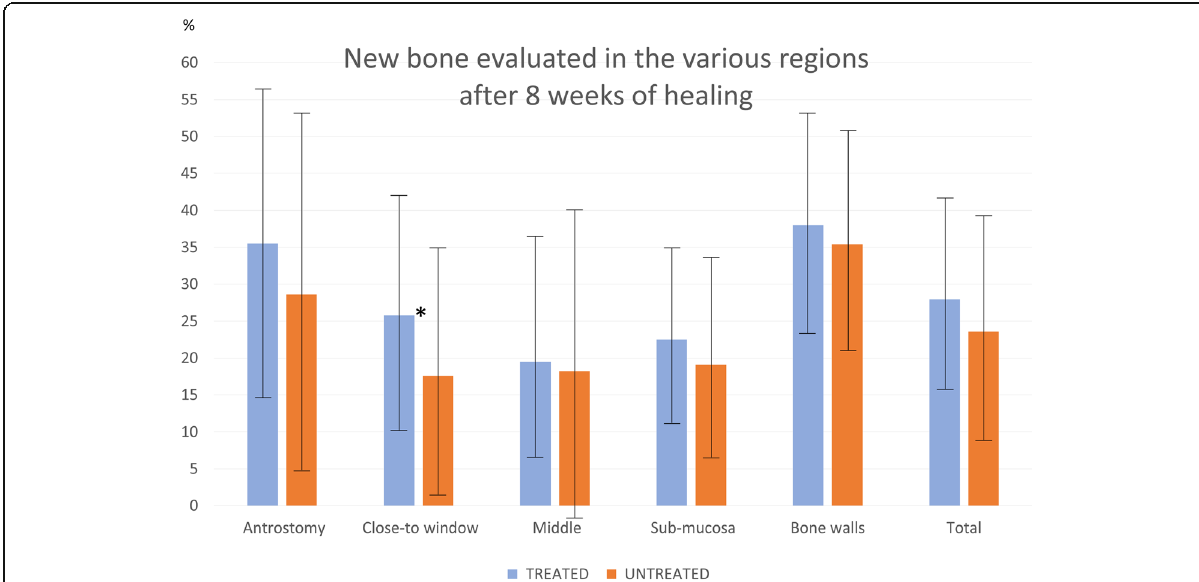
Fig. 7 Box-plot representing the new bone percentage and standard deviations (whiskers) found in the various regions evaluated after 8 weeks of healing. (*), a statistical significant difference